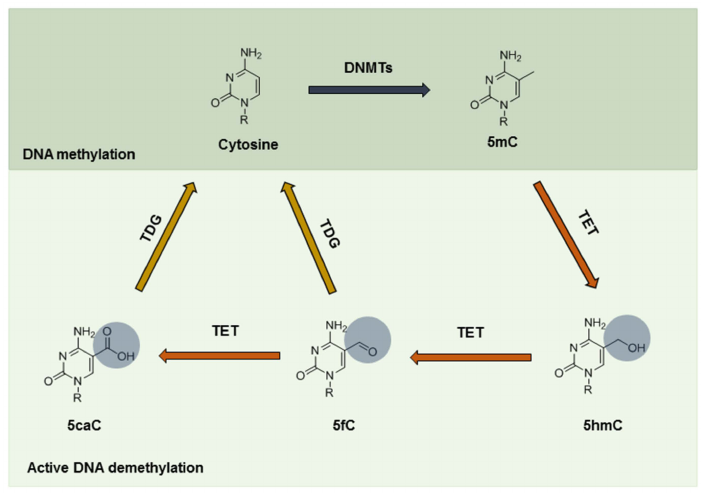
Figure 1. Chemical structures of TET-oxidized products. The DNA base cytosine can be methylated as epigenetic regulation at the DNA level by DNMTs. DNA methylation affects transcription and governs genomic stability during development as well as cancer progression. The methylated product (5-methylcytosine, 5mC) can be reversed actively by a set of enzymes, TET proteins and TDG back to cytosine. The intermediate products include: 5-hydroxymethylcytosine (5hmC), 5-formylcytosine (5fC), and 5-carboxylcytosine (5caC). The amount of 5hmC serves as a marker to indicate the status of DNA demethylation. Loss of 5hmC is often seen in cancers, particularly in myeloid and leukemia. TET: the Ten-eleven translocation family protein; DNMT: DNA methyltransferase; TDG: thymine-DNA